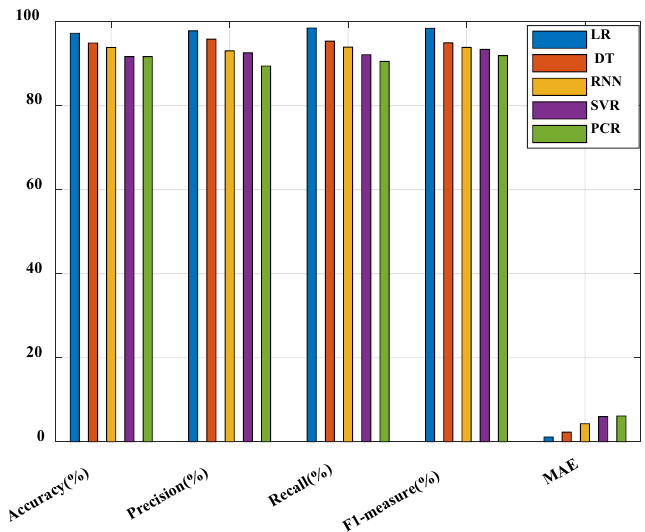
Fig. 8 Performance comparison between proposed and existing